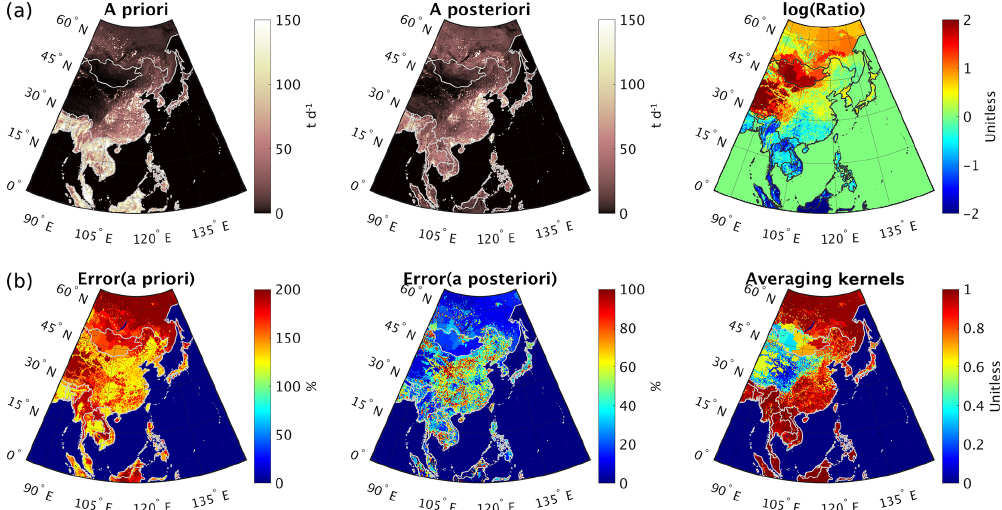
Figure 6. (a) Total VOC emissions (i.e., the a priori) constrained by the satellite observations (i.e., the a posteriori) in May–June 2016 and the natural logarithmic ratio of the a posteriori to the a priori. (b) The errors in the a priori based on Table 3, the errors in the top-down estimation, and the averaging kernels (AKs) obtained from the